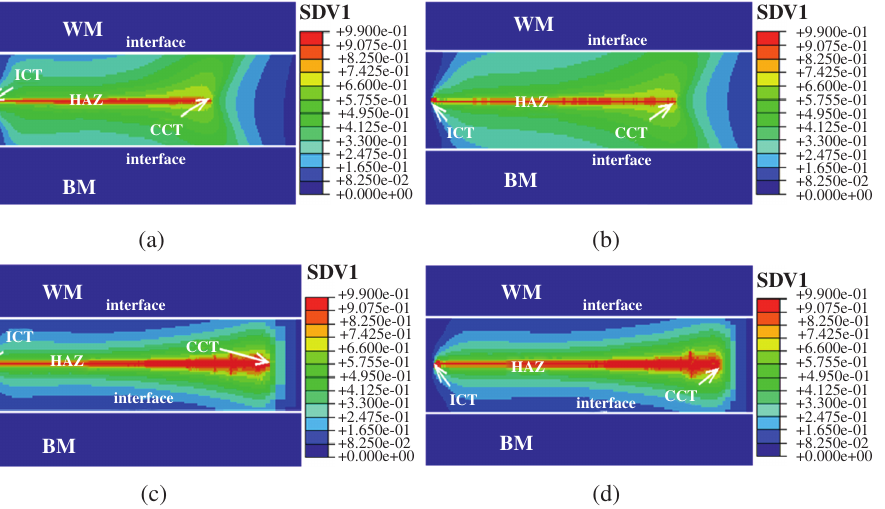
Figure 3: The final damage contours ( t / t r = 1, t r is rupture time) of CCG in welded joints: (a) mismatch MT-1, (b) mismatch MT-2, (c) mismatch CT-1 and (d) mismatch CT-2.